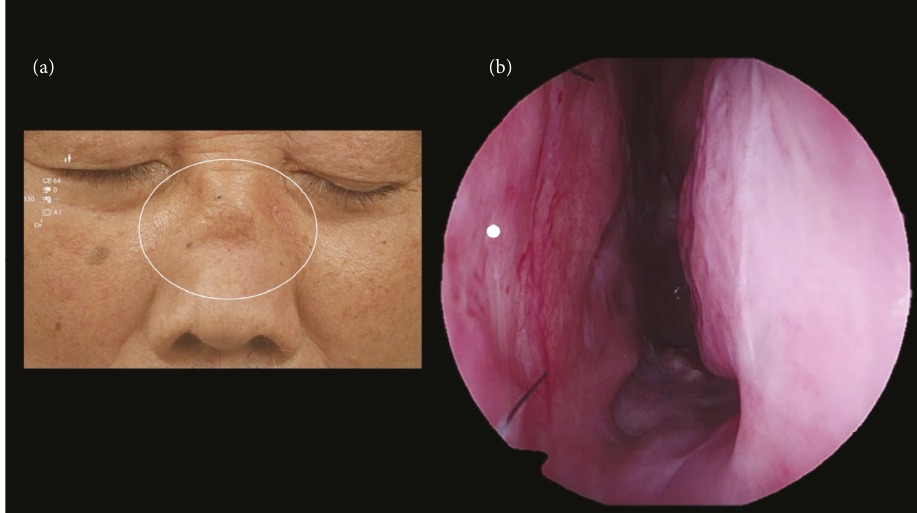
Figure 3: (a). Physical findings of the face showing a saddle nose (white circle), a typical physical finding of granulomatosis with GPA. (b). The 0 ° endoscopic findings of left nasal cavity. There is no nasal perforation after the surgery of biopsies from nasal septum (white